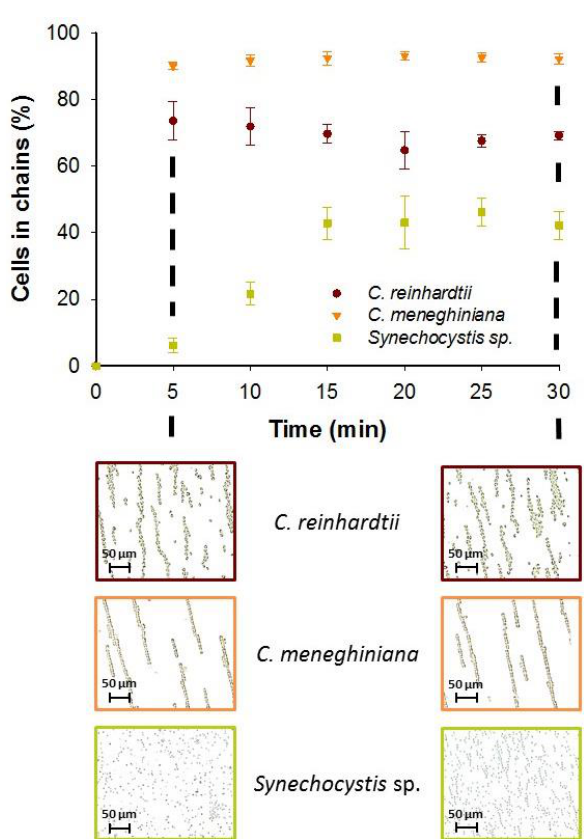
Figure 3. Effect of AC field duration on the chaining efficiency at 25 V·mm −1 and 500 kHz for C. reinhardtii , C. meneghiniana and Synechocystis sp. Micrographs obtained for each phytoplankton species after 5 min and 30 min of AC field application in Geneva Lake water. Initial concentration of C. reinhardtii and C. meneghiniana : 5 × 10 6 cells·mL −1 ; Synechocystis sp.: 5 × 10 7 cells·mL −1 .